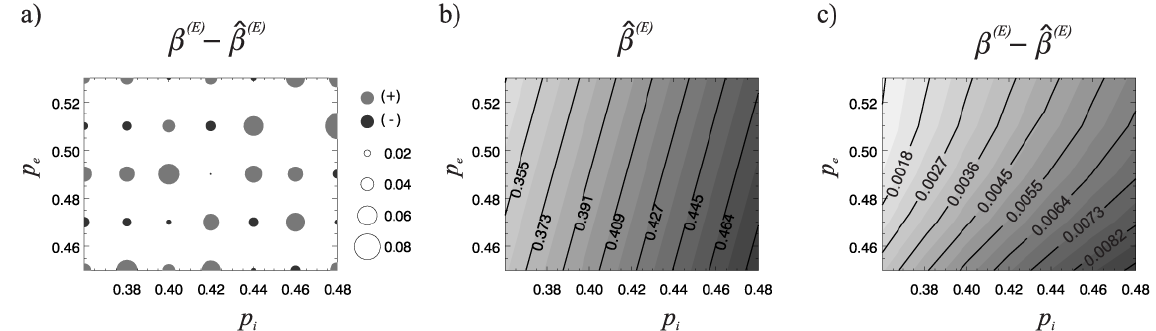
Fig. 15. Local error for estimated values, fitted plane and error of the fitted plane for the scaling exponents ˆ β (E) .